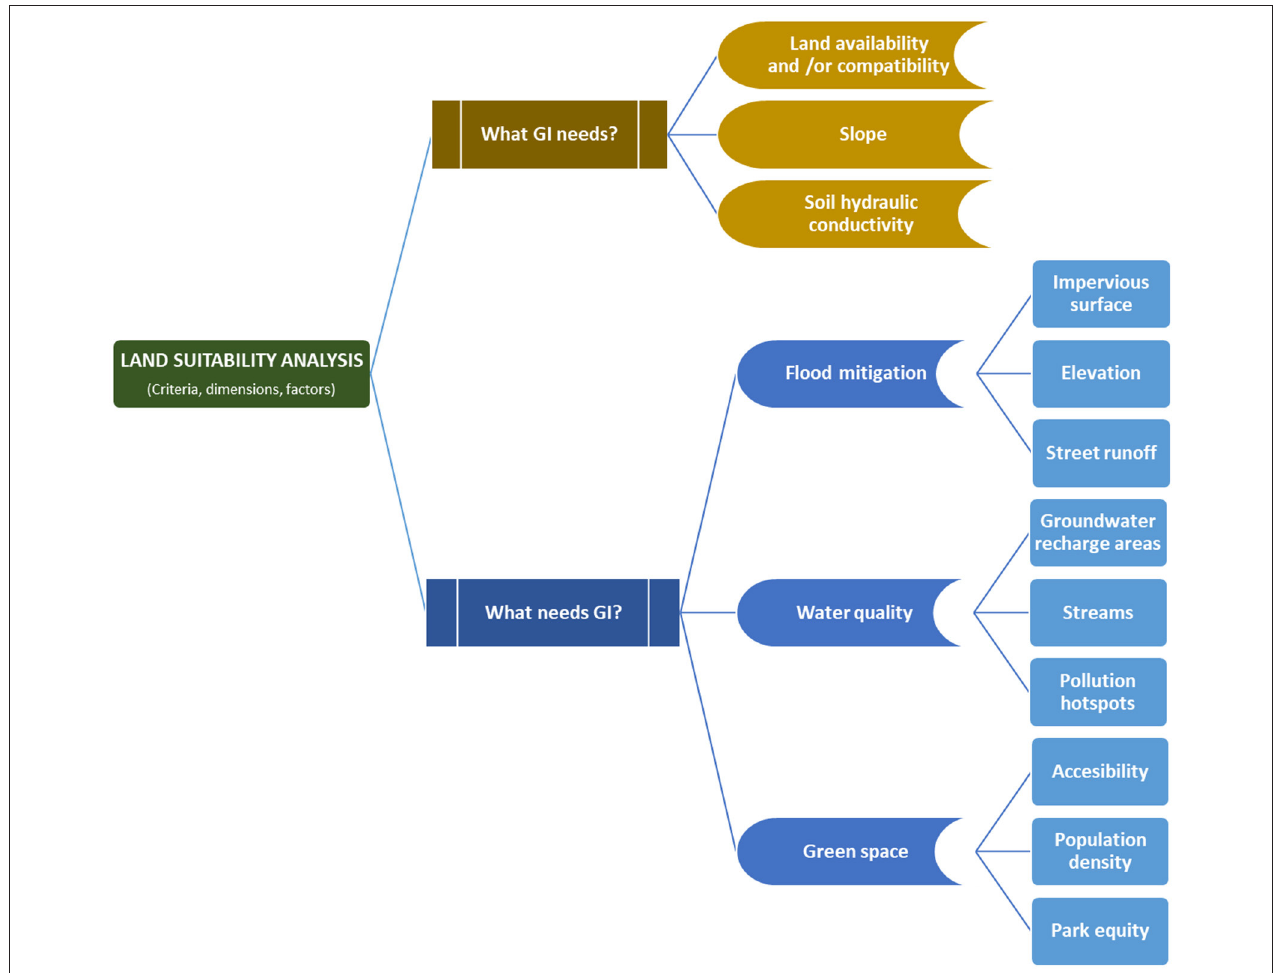
FIGURE 2 | LSA process and selection